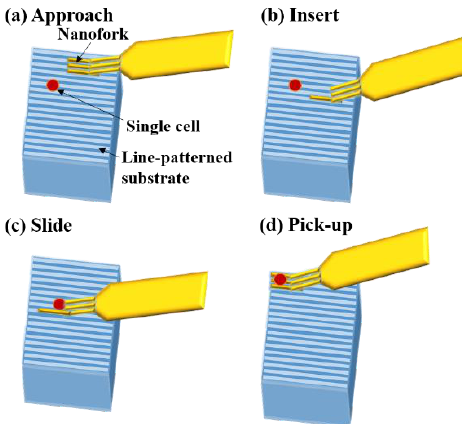
Figure 13. Overview of the: ( a ) cell pick-up and cell adhesion force measurement strategy using nanofork and line array substrate. The line array substrate enables the nanofork to be ( b ) inserted and ( c ) slid between the cell and the base of the substrate and ( d ) to pick up the cell. (Figure redrawn from [182]).